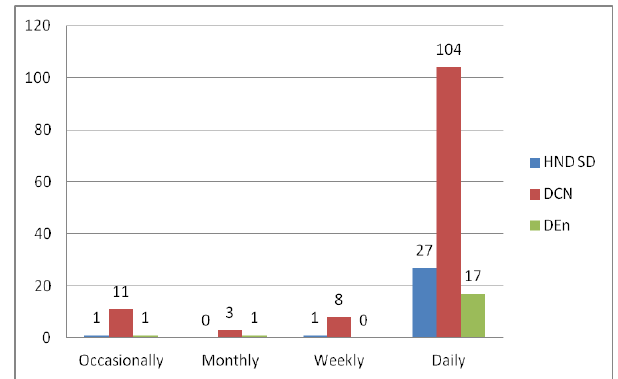
Figure 2. Frequency using Internet by